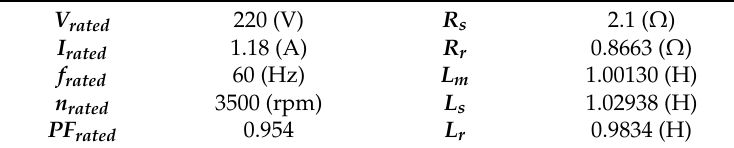
Table 1. Rated data of the induction motor (IM) used in the simulation tests.